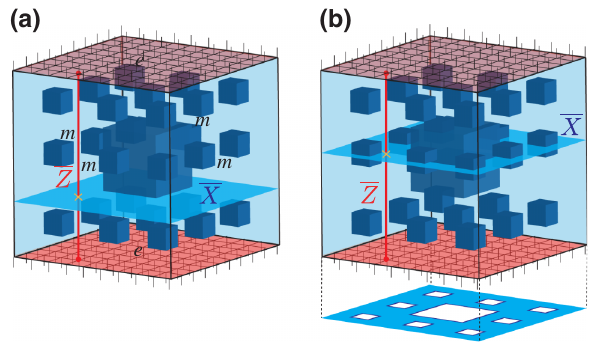
FIG. 18. (a) A pair of macroscopic logical-operator represen- tatives on the 3D fractal surface code defined on the fractal-cube geometry FC ( 3, 1 ) with m -holes: the logical string Z and the log- ical brane X . (b) The minimal area representative of the logical brane X is interrupted by the m -holes and hence has the shape of a Sierpi´nski carpet with area scaling O ( L D H ) , where D H = 1.893 is the Hausdorff dimension of the 2D Sierpi ´nski carpet.